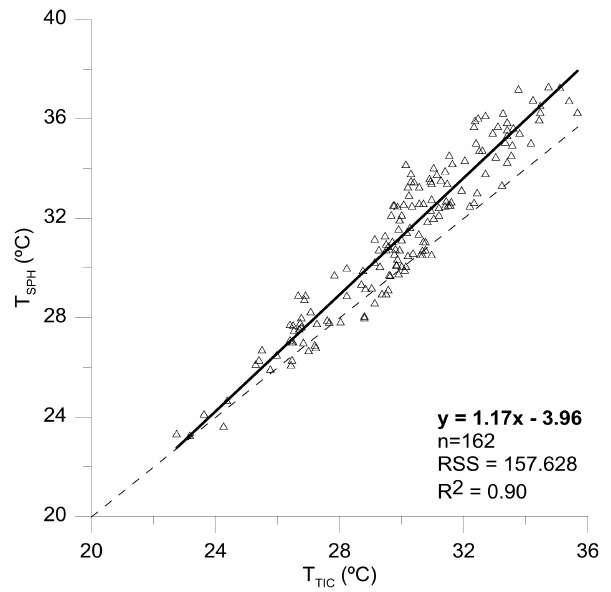
Figure 5. Linear relationship between the canopy temperature values obtained by using a Flir SC660 camera (T TIC ); a Flir One camera connected to a smartphone (T SPH ). Dotted line corresponds to the function y = x . RSS: Residual Sum of Squares.